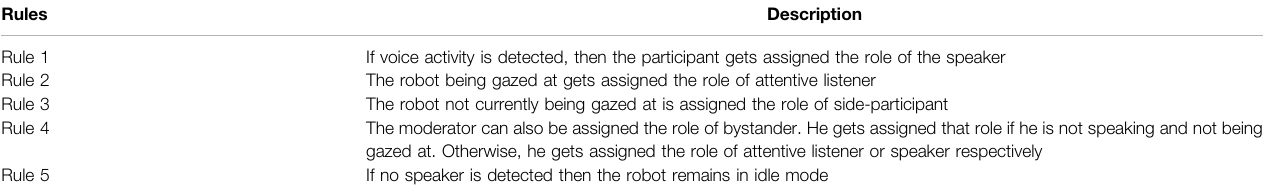
TABLE 3 | Rules for listener category assignment. Rules